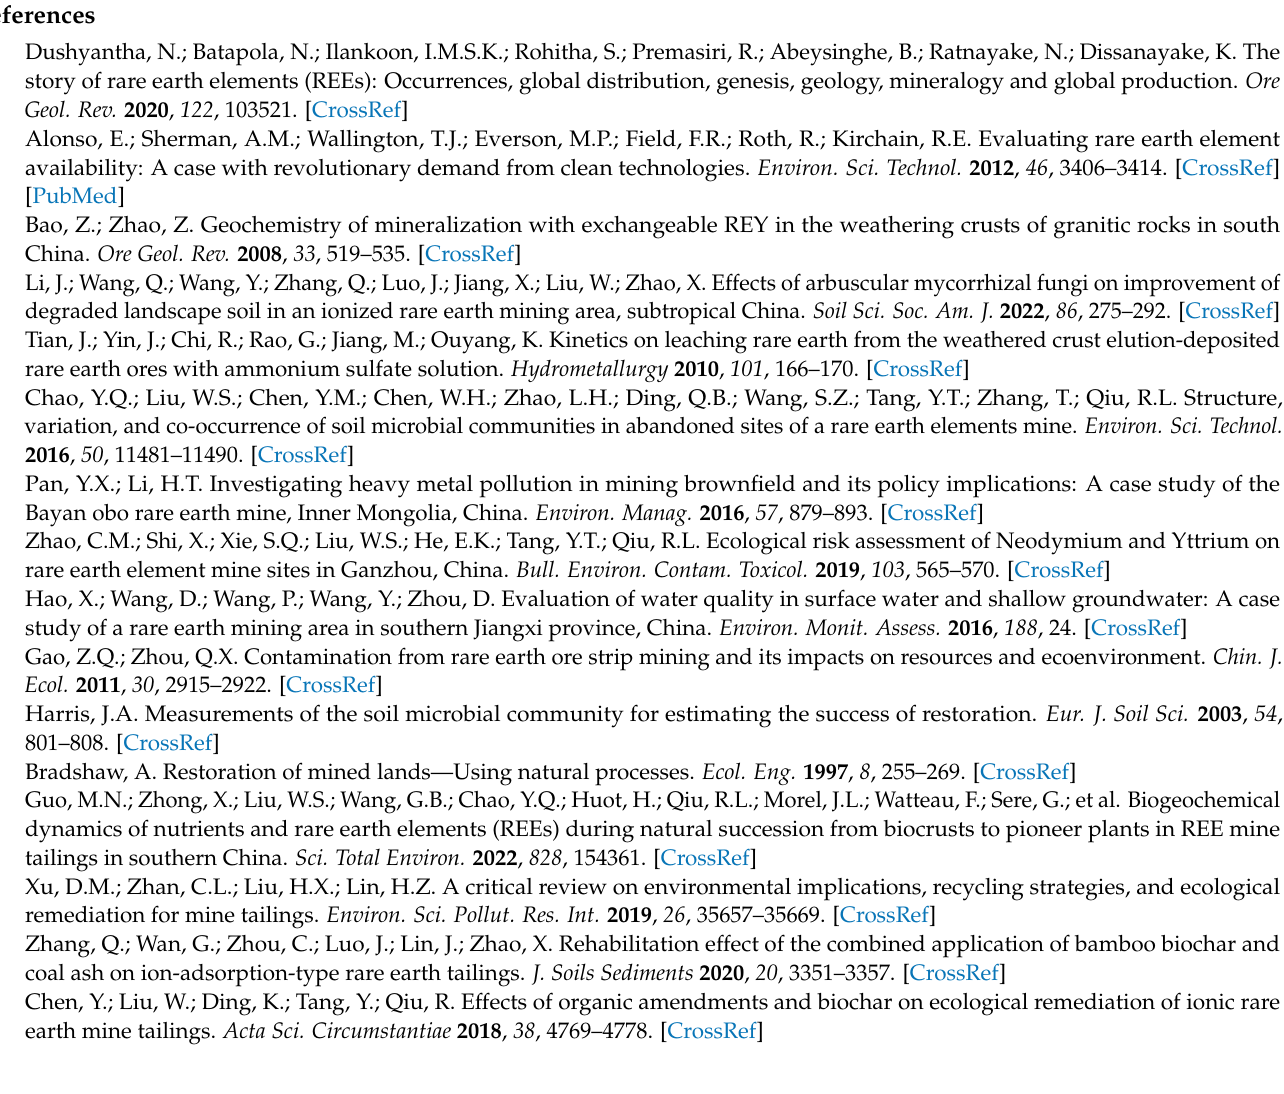
Biochar, organic fertilizer, pig manure, and cattle manure units are kg/tree. Organic